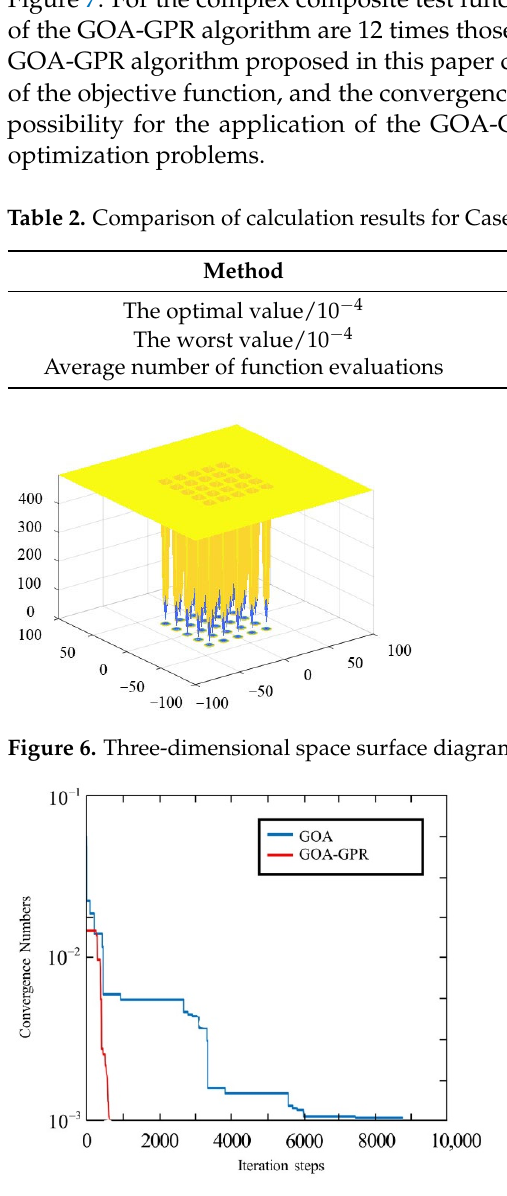
Figure 7. For the complex composite test functions, the average function evaluation times